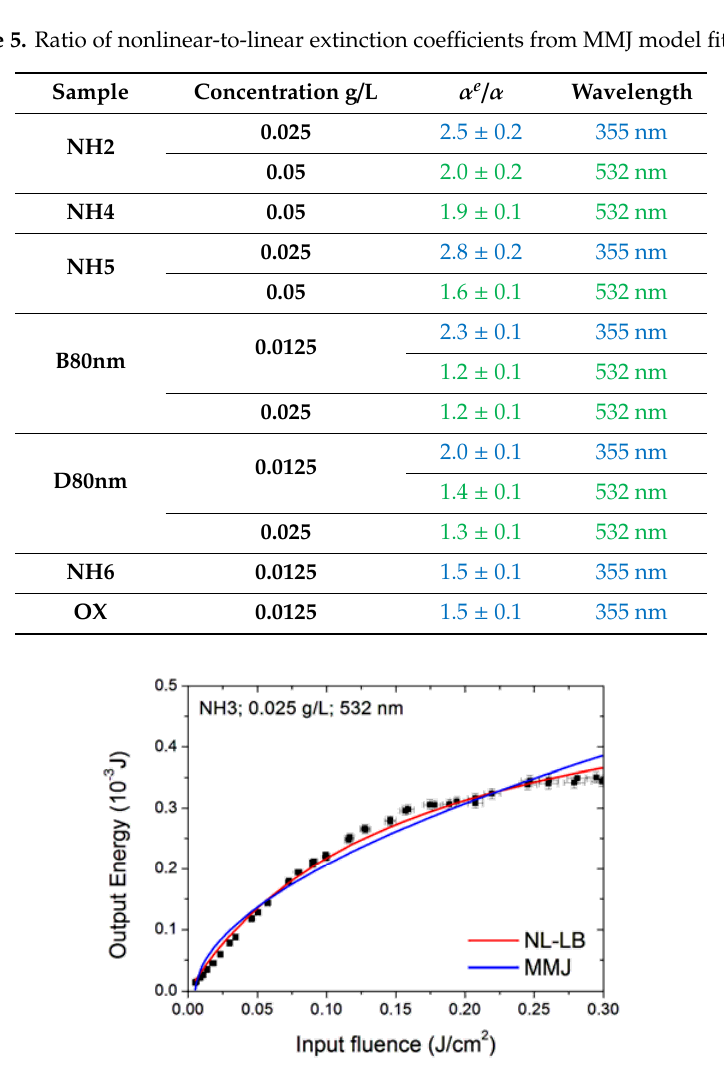
Figure 15. Strong OL in the NH3 sample for the 532 nm laser wavelength and 0.025 g / L concentration. Neither the NL-LB model (red curve) nor the MMJ model (blue curve) are able to reproduce the experimental data. Table 4. Fluence threshold values obtained from fitting.